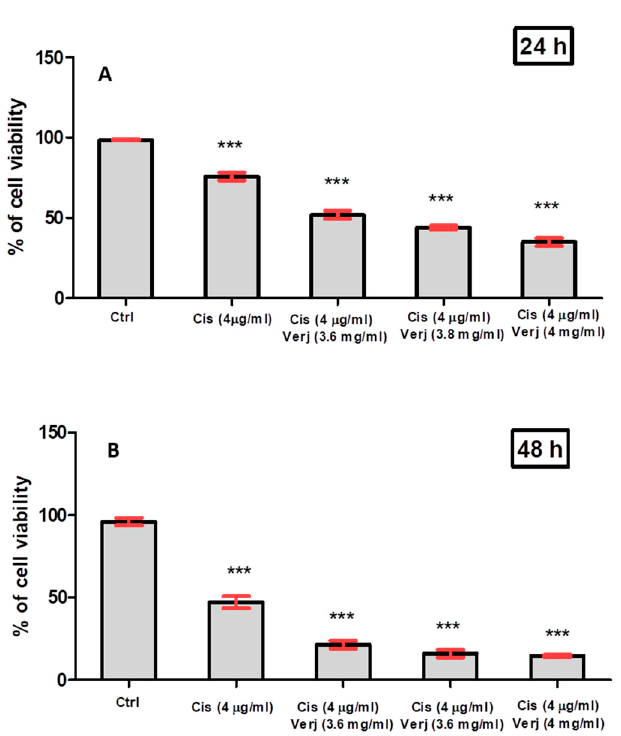
Figure 4. E ff ect of di ff erent concentrations of verjuice (Verj) in combination with cisplatin (Cis) on the survival of A549 cells after ( A ) 24 h and ( B ) 48 h of treatment. The results are expressed as the percentage of control cell (0 mg / mL cisplatin) viability (Ctrl). Each value represents the mean ± SD of triplicates obtained in five independent experiments. *** p < 0.001.